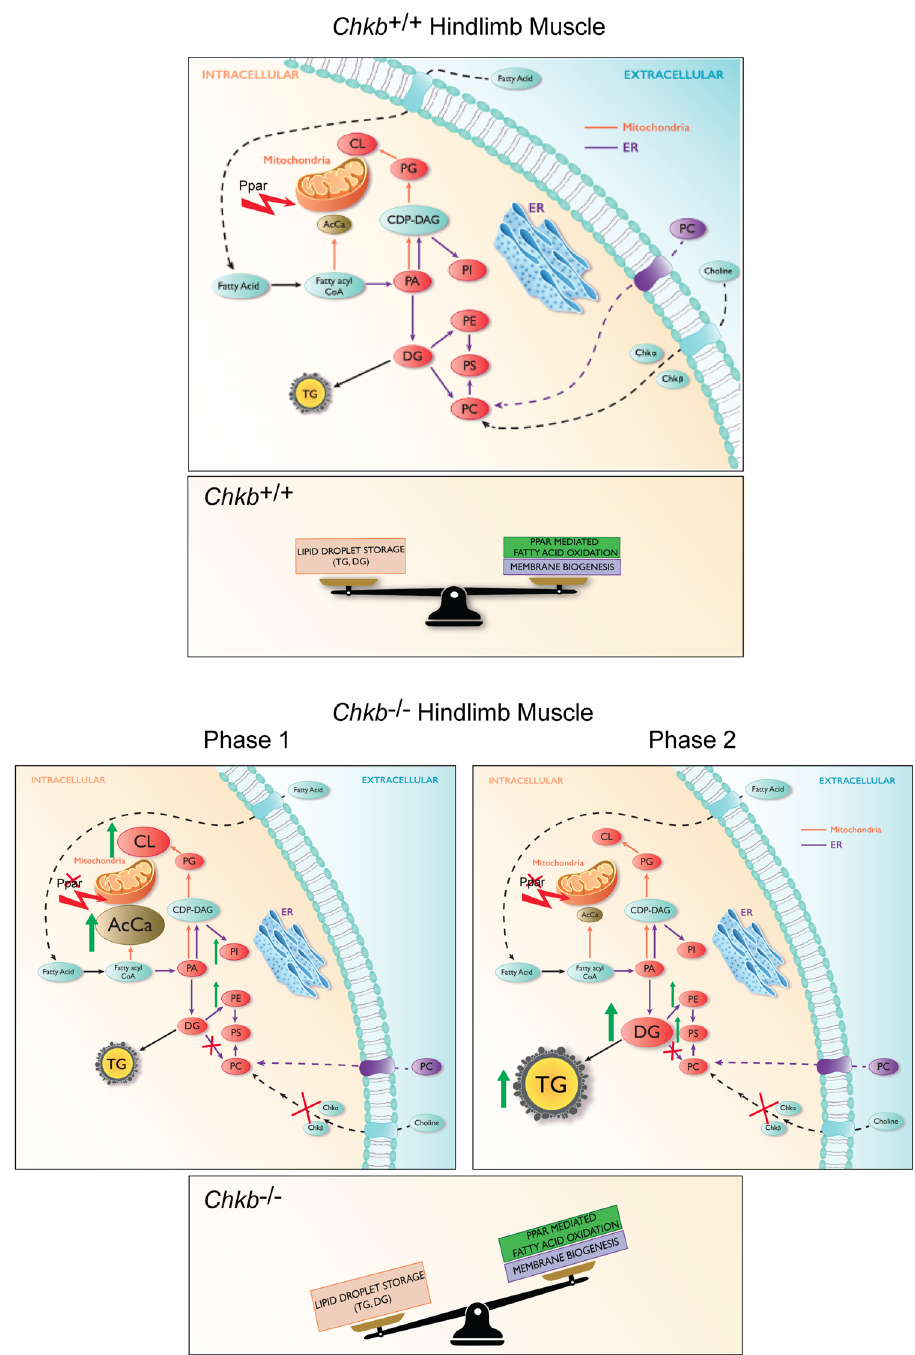
Fig. 8 Defective fatty acid utilization and lipid metabolism in Chkb − / − hindlimb muscle. In muscles from Chkb + / + mice there is a balance between storage of fatty acid as triacylglycerol (TG) and usage of fatty acids either as an energy source by mitochondria β -oxidation or membrane phospholipid synthesis. In hindlimb muscles from Chkb − / − mice, an inability to consume DG for PC synthesis results in an imbalance between storage and usage of fatty acids. Although the cells are able to increase PC uptake from plasma to compensate for defective PC synthesis, this genetic defect in PC synthesis drives large fl uctuations in lipid metabolism. At an early stage of Chkb mediated muscular dystrophy (Phase 1), there is a 12- to 15-fold increase in the levels of the mitochondrial speci fi c lipids CL and AcCa; the large increase in CL re fl ects the increase in mitochondrial size at this stage of the disease. The increase in AcCa level is likely due to the inability to consume DG for PC synthesis, resulting in an accumulation of its precursor-fatty acid which the cell attempts to consume via mitochondria β -oxidation, however there is a concomitant decrease in Ppar mediated expression of genes required for fatty acid conversion to AcCa for its import into mitochondria and consumption by β -oxidation. As the disease progresses (Phase 2), CL level returns to wild type (probably as a result of damaged mitochondrial inner membrane), and a 12-fold increase in the storage lipid TG occurs due to an inability consume AcCa and the shunting of fatty acids into storage lipid droplets.